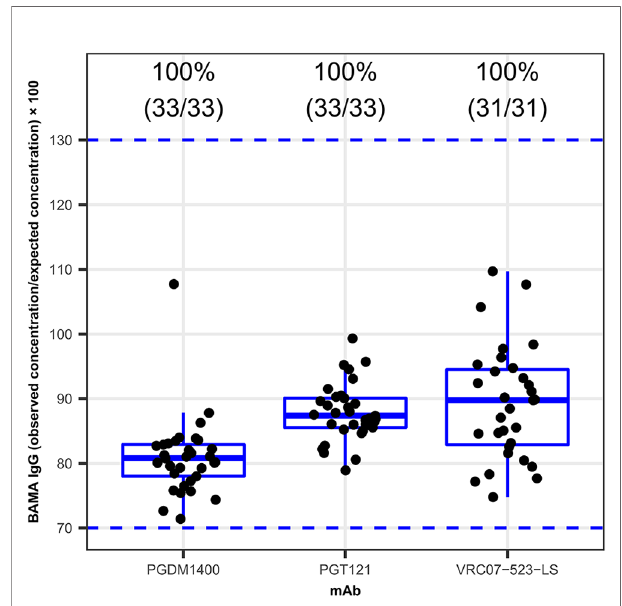
FIGURE 3 | Positivity of the PGDM1400, PGT121 and VRC07-523-LS Triplex PK. 33 HIV-1 seronegative serum samples were spiked with speci fi c concentrations of the PGDM1400, PGT121, and VRC07-523-LS. Percent recovery, calculated as (observed concentration ÷ expected concentration) × 100, for PGMD1400, PGT121 and VRC07-523-LS, respectively is shown on y-axis. The blue dashed lines at levels 70 and 130, show preset acceptance criteria for percent recovery [70-130%]. Numbers on top of each box plot show the percentage and counts (number of samples that met the present acceptance criteria/total number of samples) of samples with a percent recovery between 70-130%. 100% of the samples, for all three bnAbs tested here, had acceptable percent